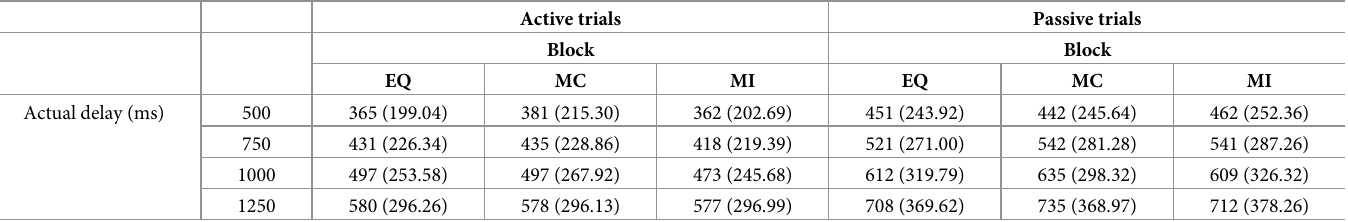
Table 1. Means (SD) for the estimated delays (in ms) in relation to block (EQ, MC, MI) and actual delay (500, 750, 1000 or 1250ms) for the active and passive trials.